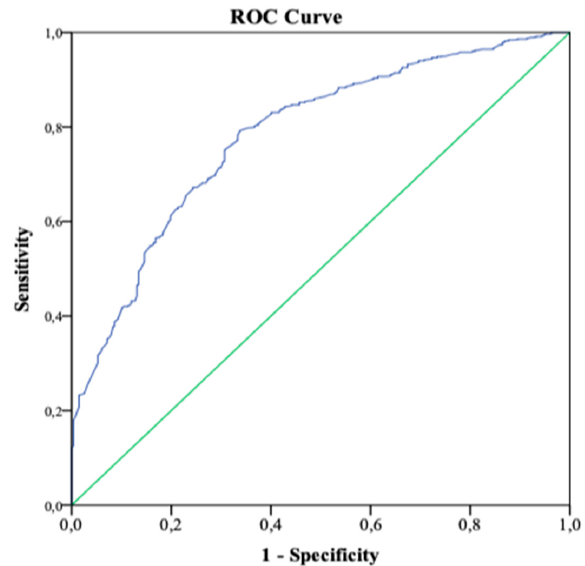
Figure 1. Predictive capacity of the model. The area under the ROC curve determines the predictive ability of the model in the study cohort. Sensitivity on the y-axis and 1-specificity on the x-axis. The predictive capacity (AUC-ROC) is 0.78 (95% CI: 0.75–0.81), as shown in Figure 1. Therefore, the predictive capacity is considered acceptable by the Swets criteria.